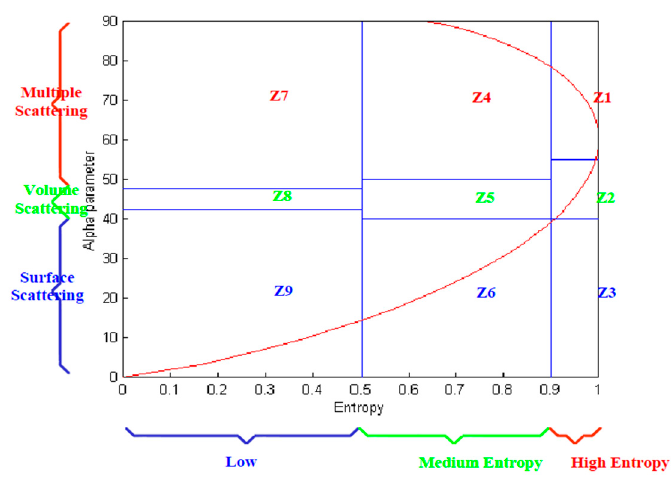
Figure 4. Segmentation of the H/ α space [19].